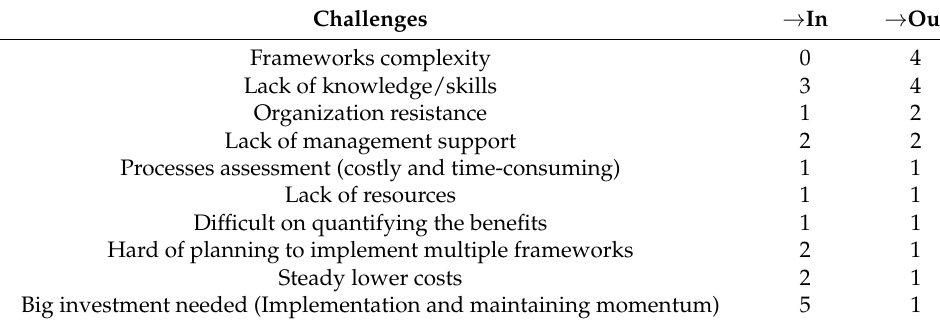
Table 7. Relation between Challenges and